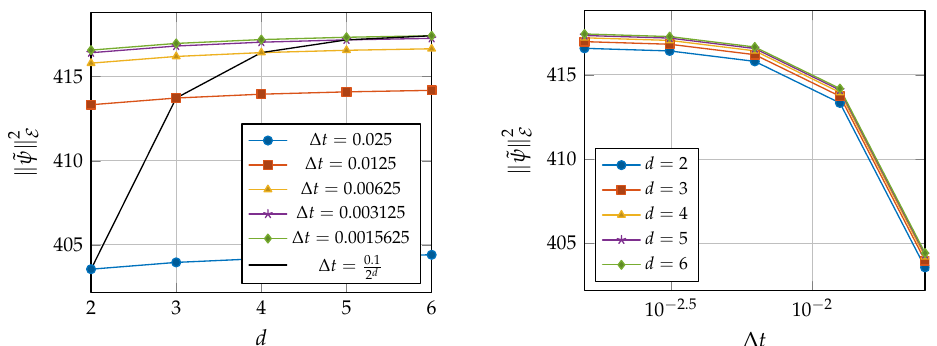
Figure 25. Squared space-time energy norm (60) of the approximated density on the S-shaped scatterer versus increasing B-spline degree (left) and refined time discretization (right).